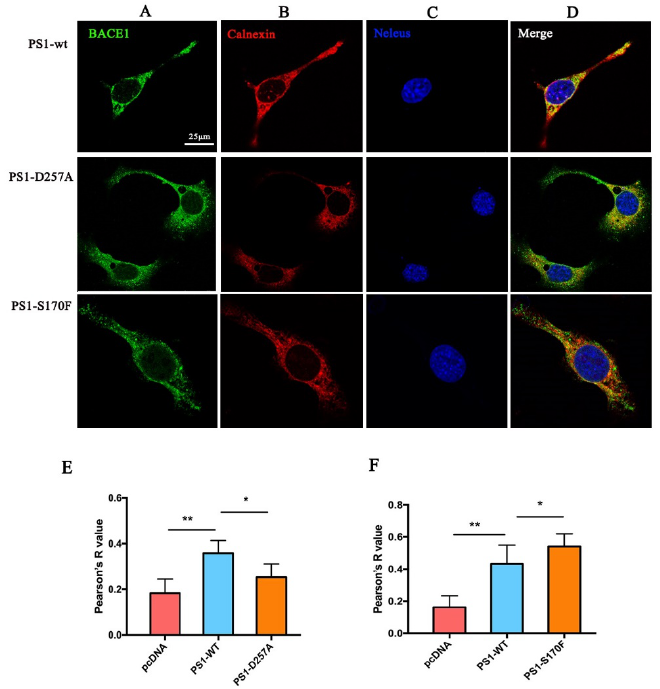
Figure 7. Effect of PSEN1 mutations on colocation of BACE1 and the ER (scale bar = 25 μm). ( A ) BACE1. ( B ) Calnexin. ( C ) Nucleus (Hoechst33258). ( D ) Merged picture. Quantification of the colocalization ratio of BACE1 and the ER under PSEN1 mutations D257A ( E ) and S170F ( F ). One-way ANOVA: ** p < 0.01, * p < 0.05 ( n = 3). Int. J. Mol. Sci. 2022 , 23 , x FOR PEER REVIEW